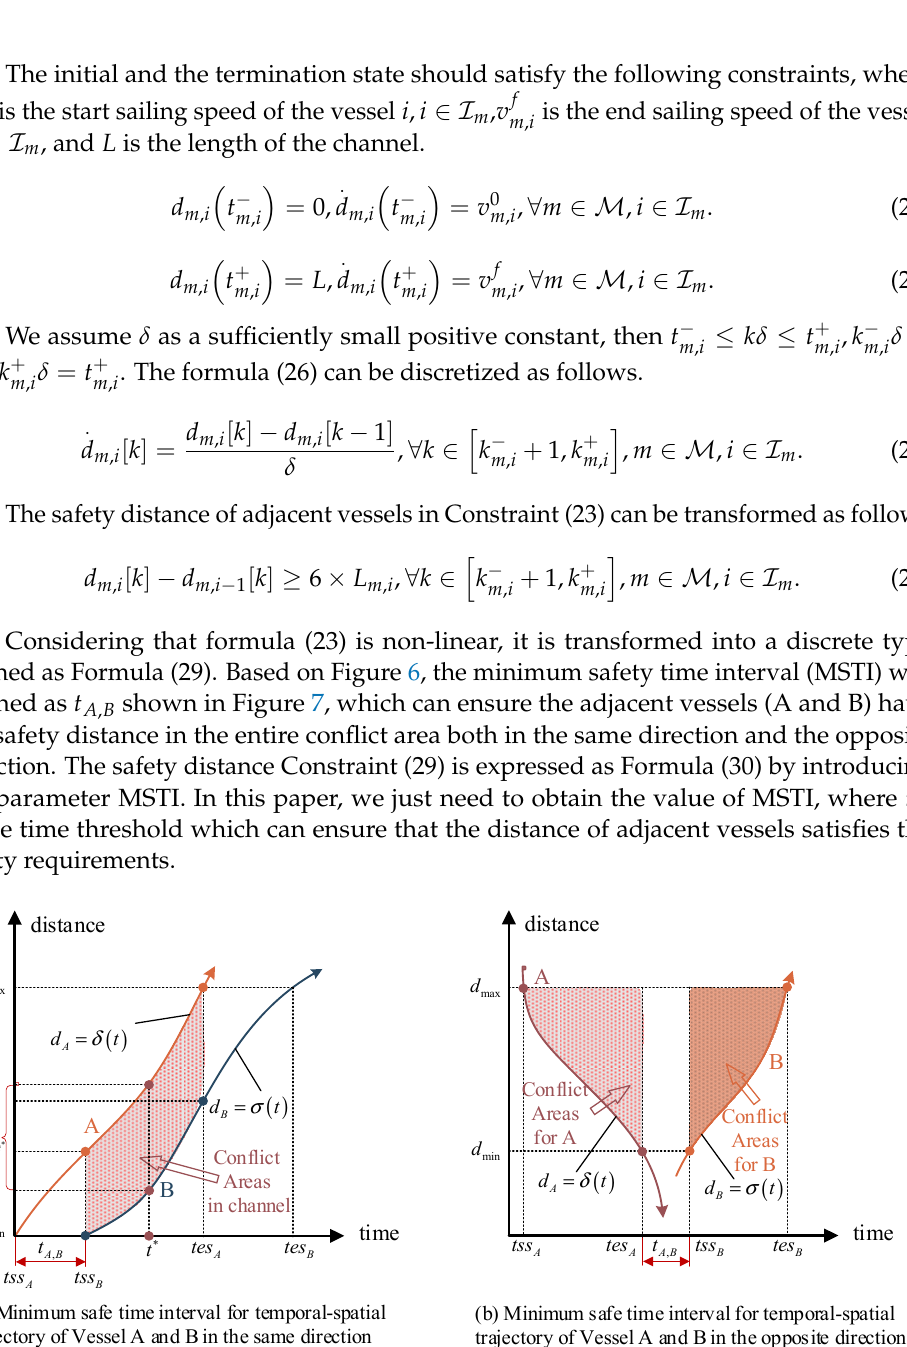
Figure 7. The minimum safe time window between two vessels.